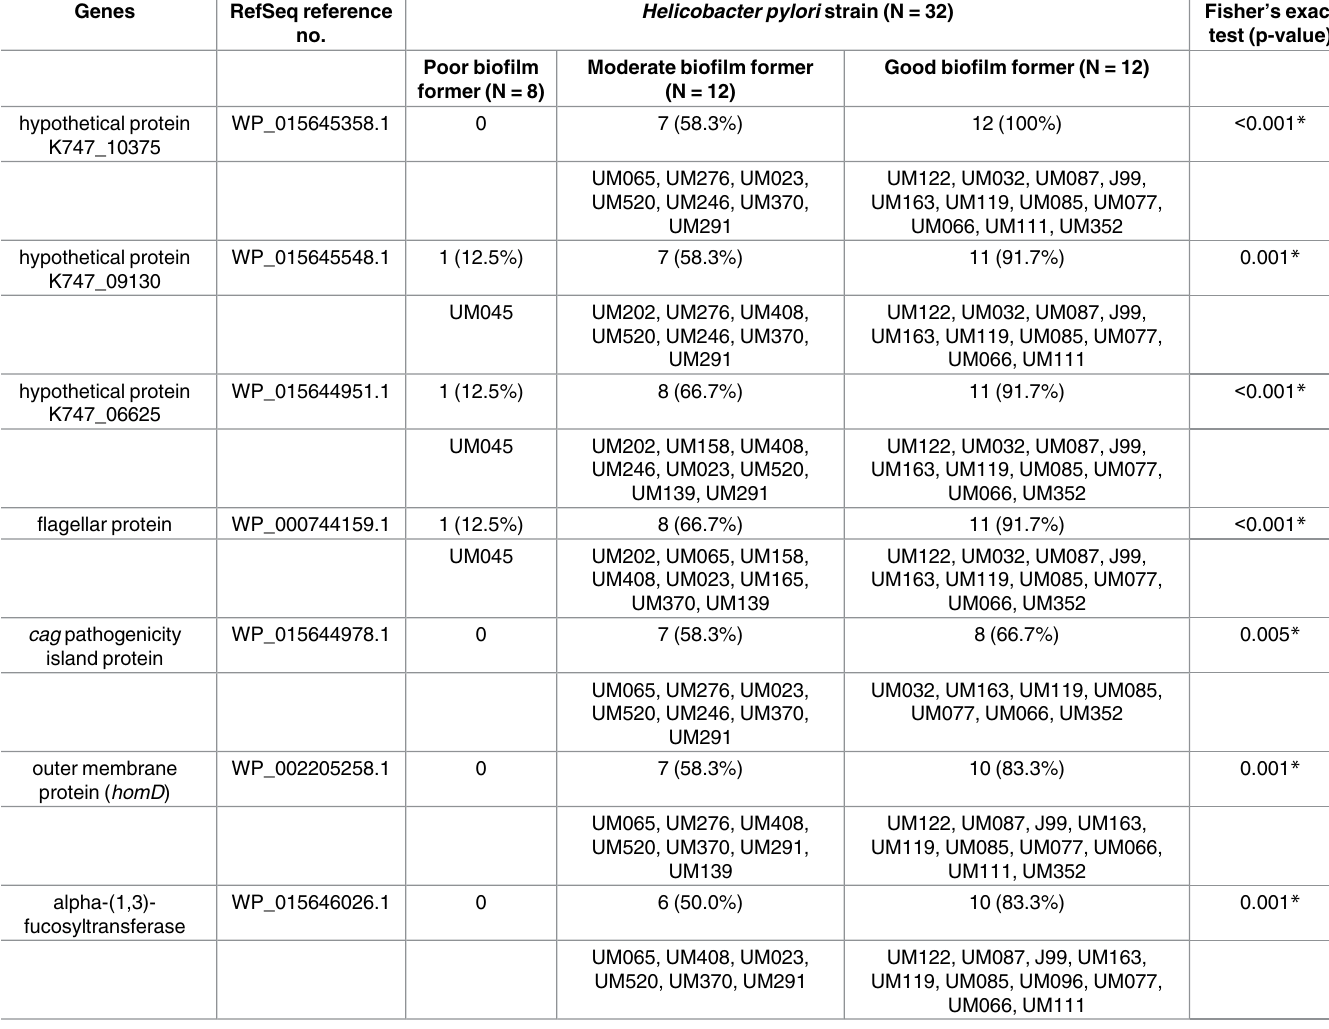
Table 5. Genes with significant association with biofilm formation (p-value < 0.05) confirmed by PCR. Genes RefSeq reference